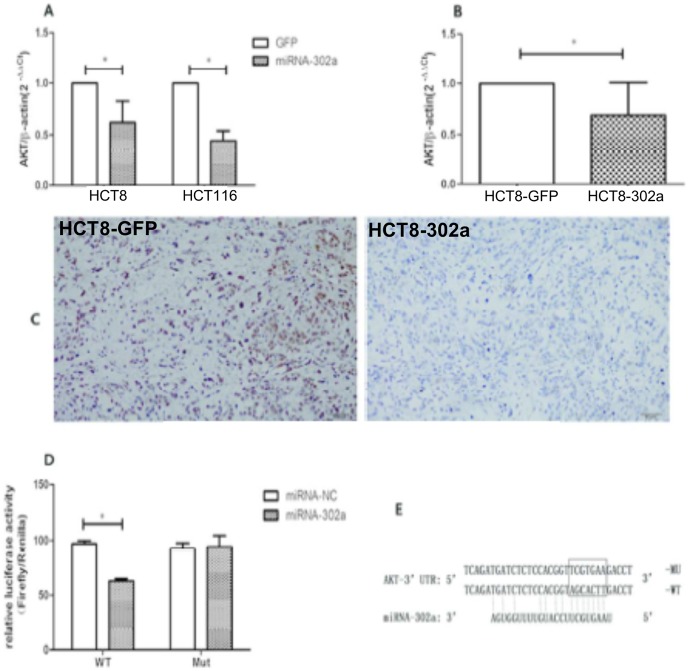
MiRNA-302a suppresses AKT expression by directly targeting its 3′ untranslated region.
AKT mRNA expression was remarkably suppressed in (A) HCT8-302a and HCT116-302a cells, and (B) HCT8-302a tumors. (C) Immunohistochemistry staining indicated lower expression of AKT in HCT8-302a tumors. (D) Relative luciferase activity was notably suppressed in wild-type AKT-3′ untranslated region (UTR) transfected cells. (E) Schematic representation of the luciferase reporter, which carried the wild-type or mutant AKT-3′ UTR. (* P<0.05).